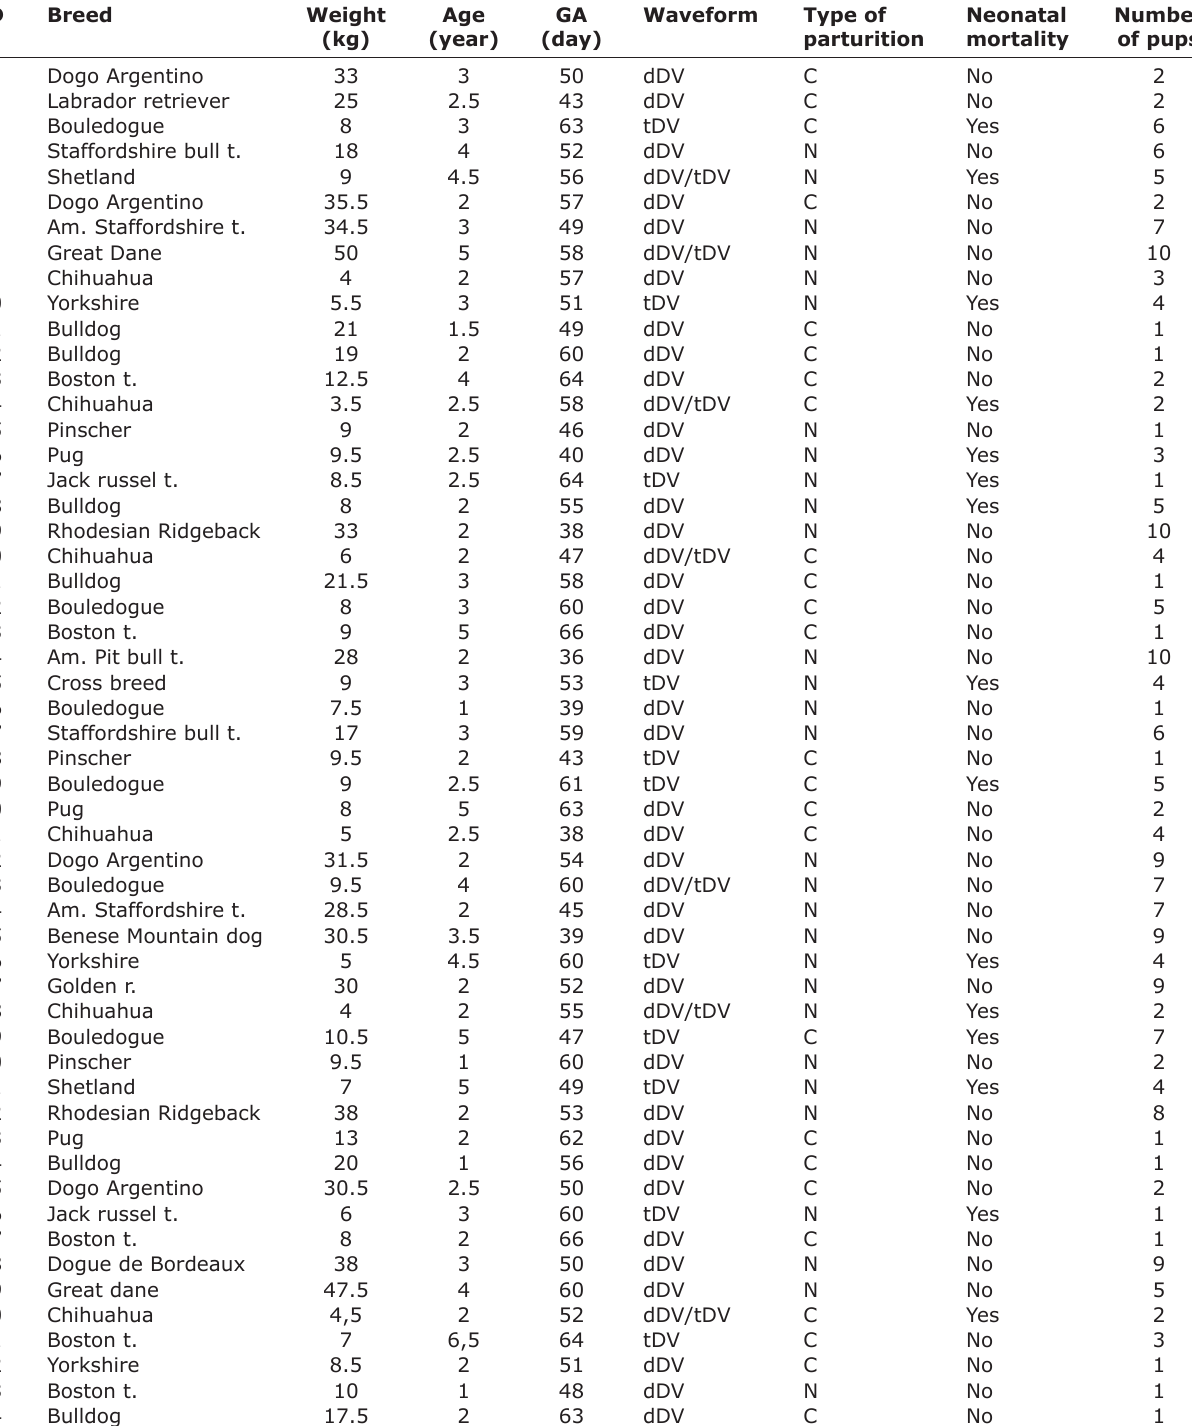
Table-1: Table summarizing population